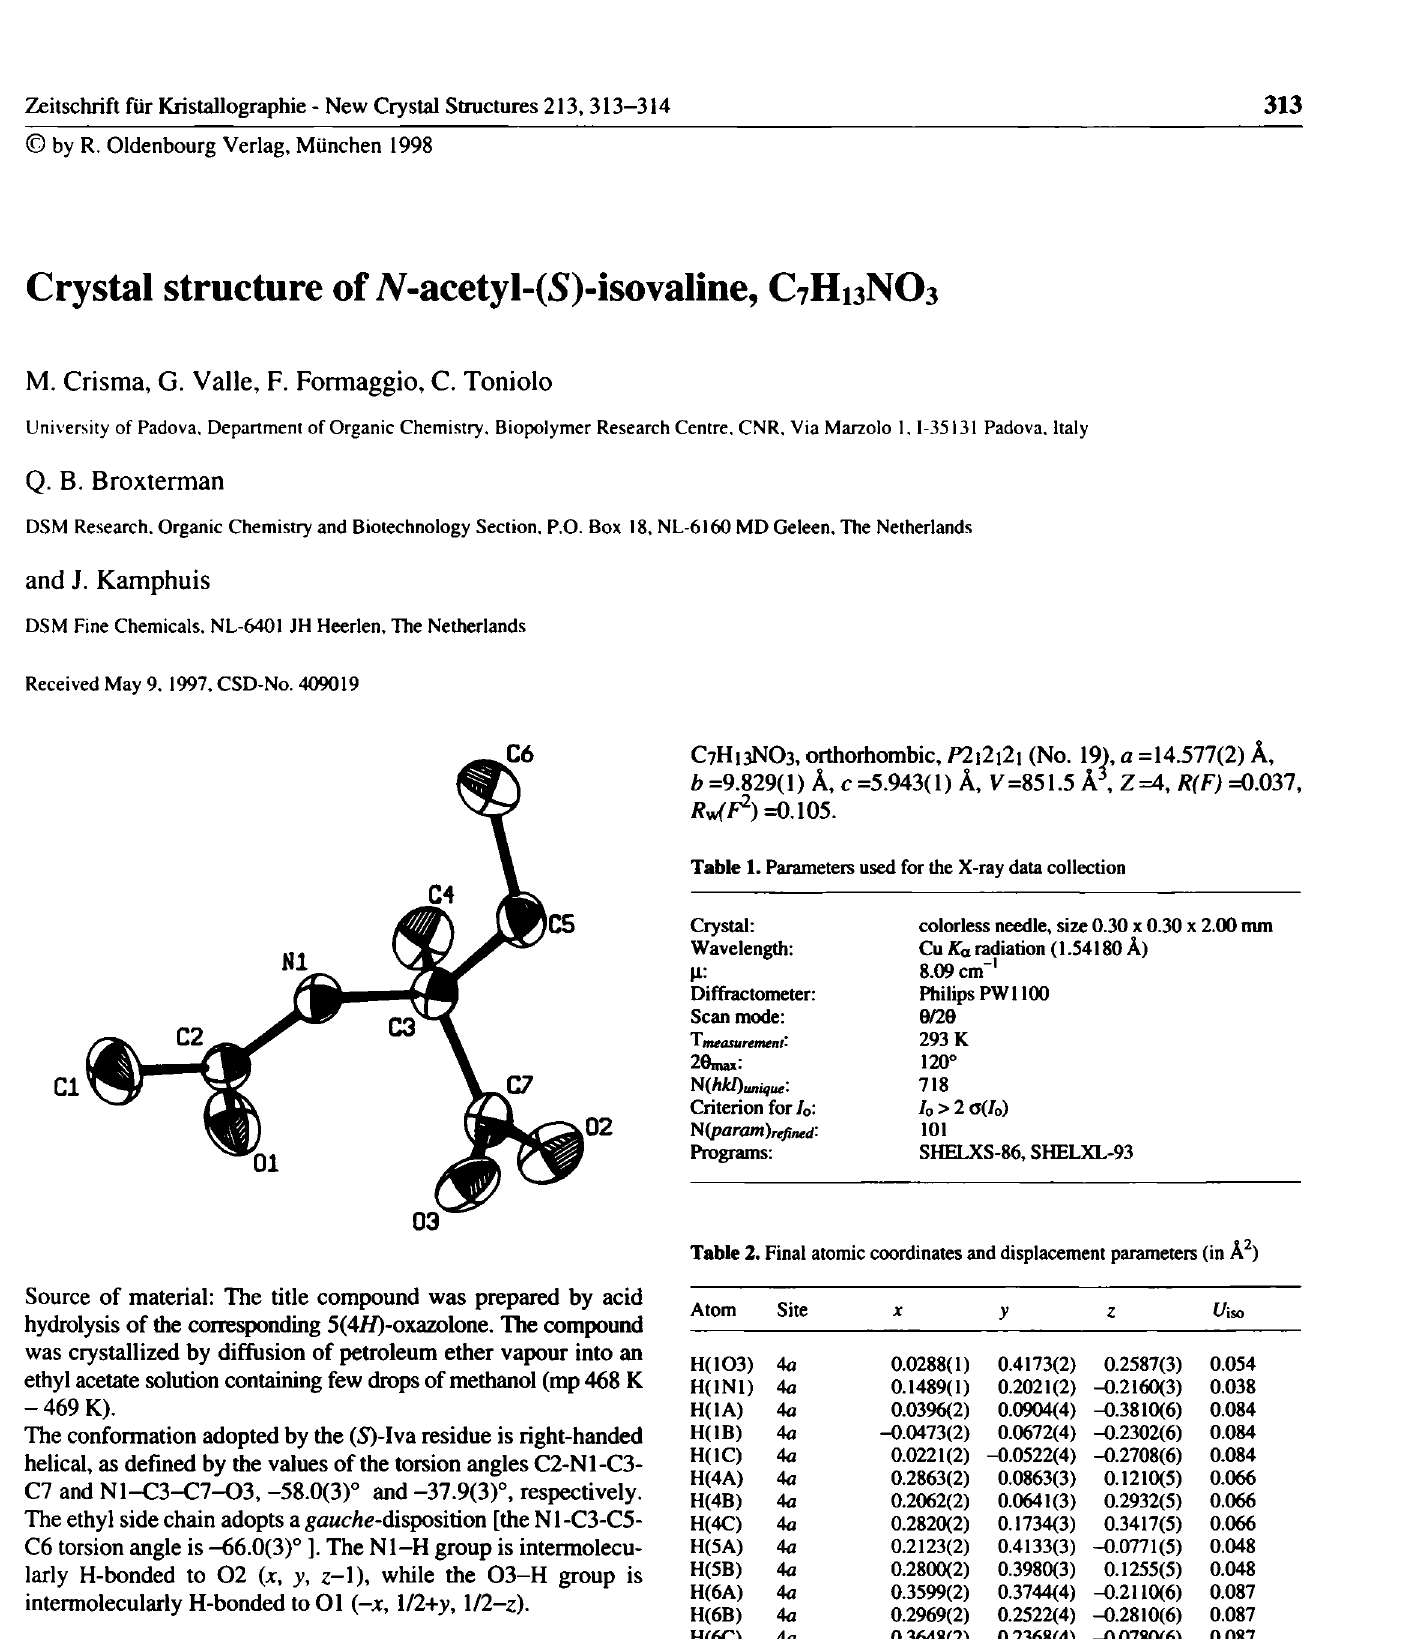
Table 3. Final atomic coordinates and displacement parameters (in Â^)